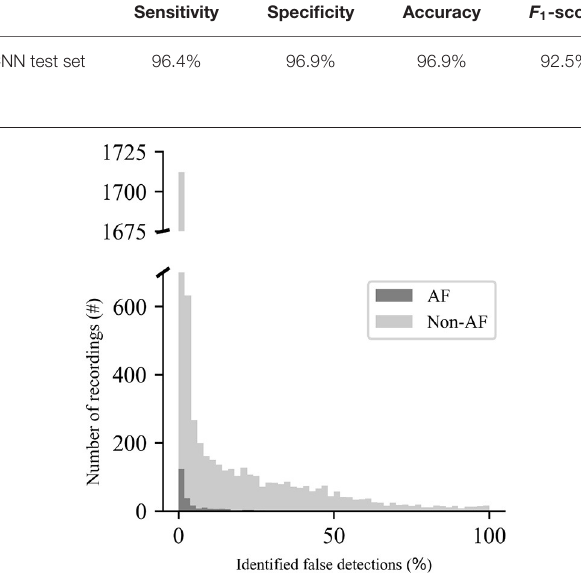
FIGURE 4 | Percentage of the total number of detections belonging to the recordings in the category irregular rhythm identified as false